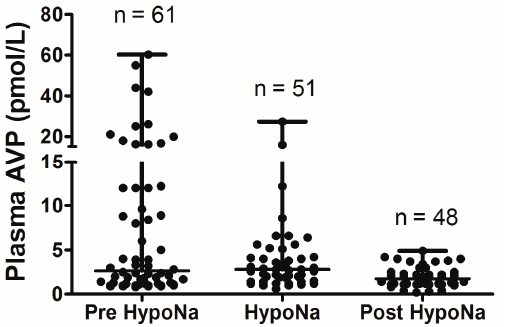
Figure 1. Comparison of arginine vasopressin (AVP) levels before the development of hyponatremia, during the hyponatremic episode, and after resolution of hyponatremia, in patients with SIADH following Subarachnoid Hemorrhage (SAH); AVP levels are significantly higher before and during episode of hyponatremia when compared with after resolution of hyponatremia ( p = 0.03); adapt from [6] with